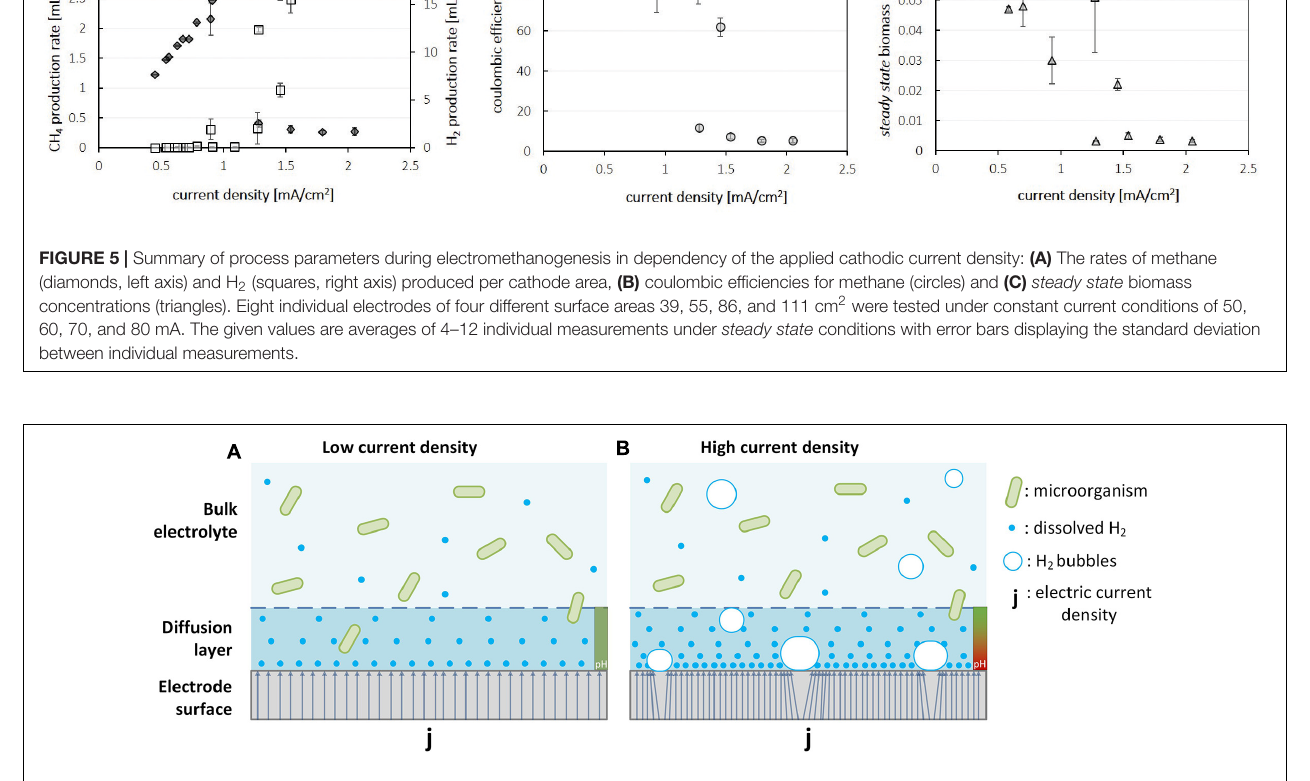
FIGURE 6 | Conceptual representation of the fate of H 2 in a (A) single-phase system at low current density and (B) gas-evolving system at high current density on a hydrogen producing cathode during electrosynthesis. The concentration of dissolved H 2 in the bulk aqueous phase is lower than in the boundary layer because of microbial consumption. If the cathodic current density produces dissolved H 2 at a rate that exceeds its diffusion out of the boundary layer and microbial consumption, bubble formation will occur (B) . Hydrogen gas bubbles can passivate the active catalytic surface area of the cathode and, thus, reduce electric efficiencies. If mass transfer from gaseous H 2 in bubbles to dissolved H 2 in the bulk electrolyte is limited, there is a net loss of H 2 from the reaction space which reduces coulombic efficiency as well as volumetric production rates. When the electrocatalytic H 2 production exceeds the rate at which protons diffuse into the boundary layer, the local pH will rise to alkaline levels (indicated red, see B ) potentially toxic to the microorganisms. With increasing current density, number and size of bubbles will increase and with that the intensity of all associated